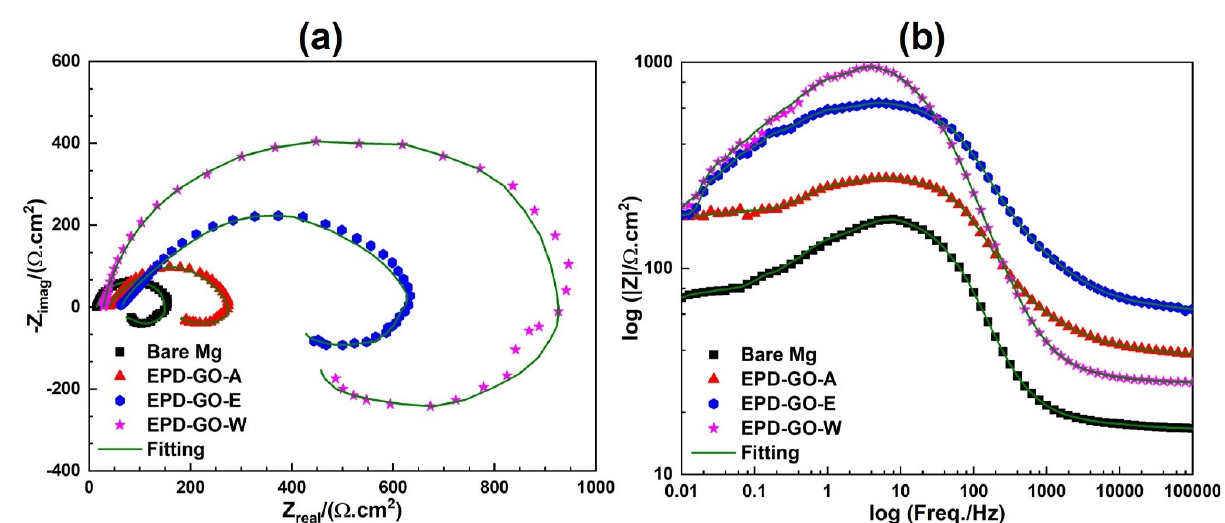
Figure 8. Fitted ( a ) Nyquist and ( b ) bode plot of uncoated and EPD-GO-coated Mg samples.